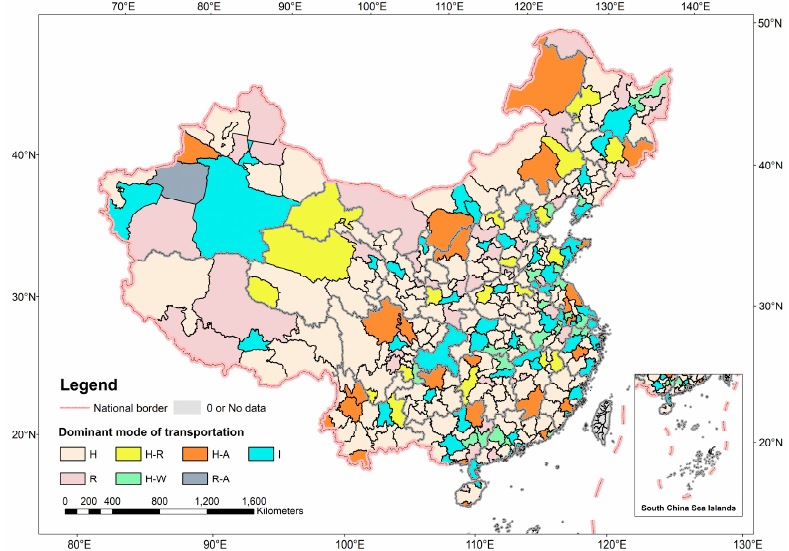
Figure 3. Dominant mode of transportation in prefecture-level cities.